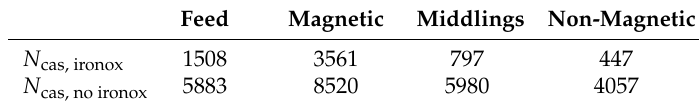
Table 7. Number of particles in the feed and three products classifying, N cas, ironox , particles containing cassiterite and iron oxides and N cas, no ironox as particles includes cassiterite and no iron oxides.